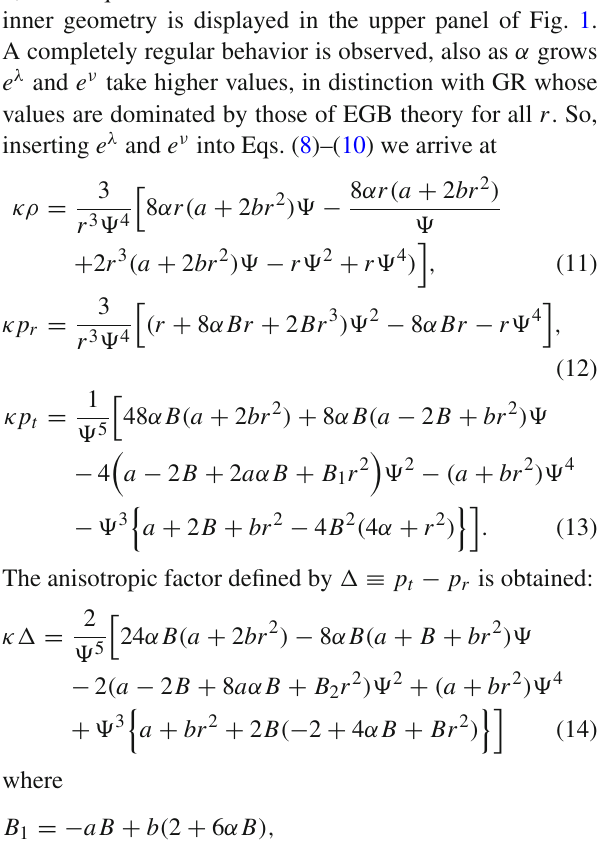
1and e ν( r ) | r = 0 = C 2 ,whichimplies ( e λ ) (cid:5) | r = 0 = ( e ν ) (cid:5) | r = 0 = 0, as is required for a well behaved model. The trend of the inner geometry is displayed in the upper panel of Fig.